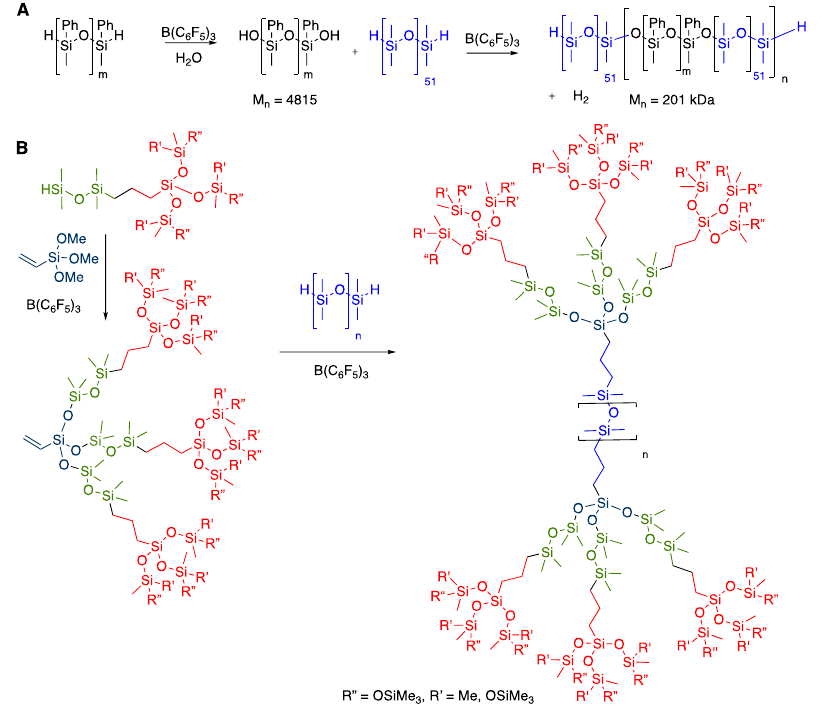
Figure 2. ( A ) Polymerization of telechelic HSi-silicones and water to give block copolymers. ( B ) Formation of highly branched silicones using the PCRK (Piers–Chojnowski–Rubinsztajn–Kawa- kami)